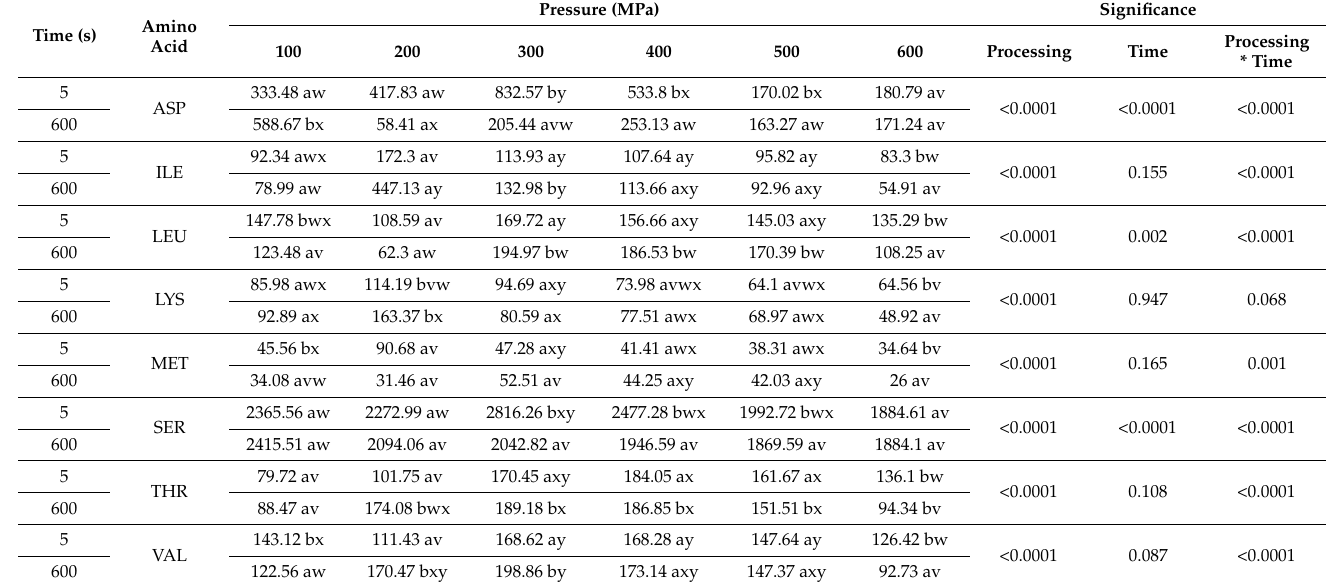
Table 1. Free amino acid composition of Diamond Shell ( Spisula aequilatera ) clams. a,b means with different letters in a row show the significant effect of time in each processing pressure; v,w,x,y,z means with different letters in column show the significant effect of time under the same processing pressure. * Compounds identified with VID coefficients higher than 0.8.